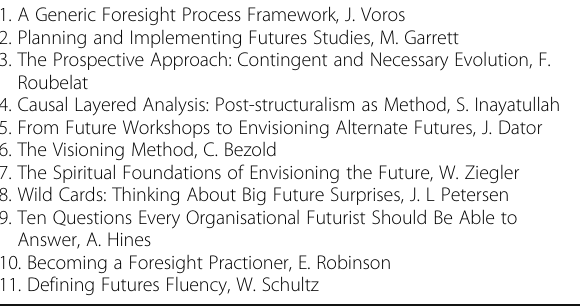
Table 1 Chapters from Knowledge Base of Futures